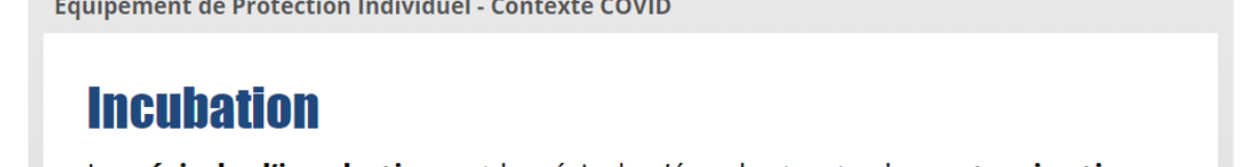
Figure 1. Use of pretesting to promote acquisition of knowledge regarding incubation time. The virus must be placed on the timeline before the Valider (Validate My Answer) button can be successfully